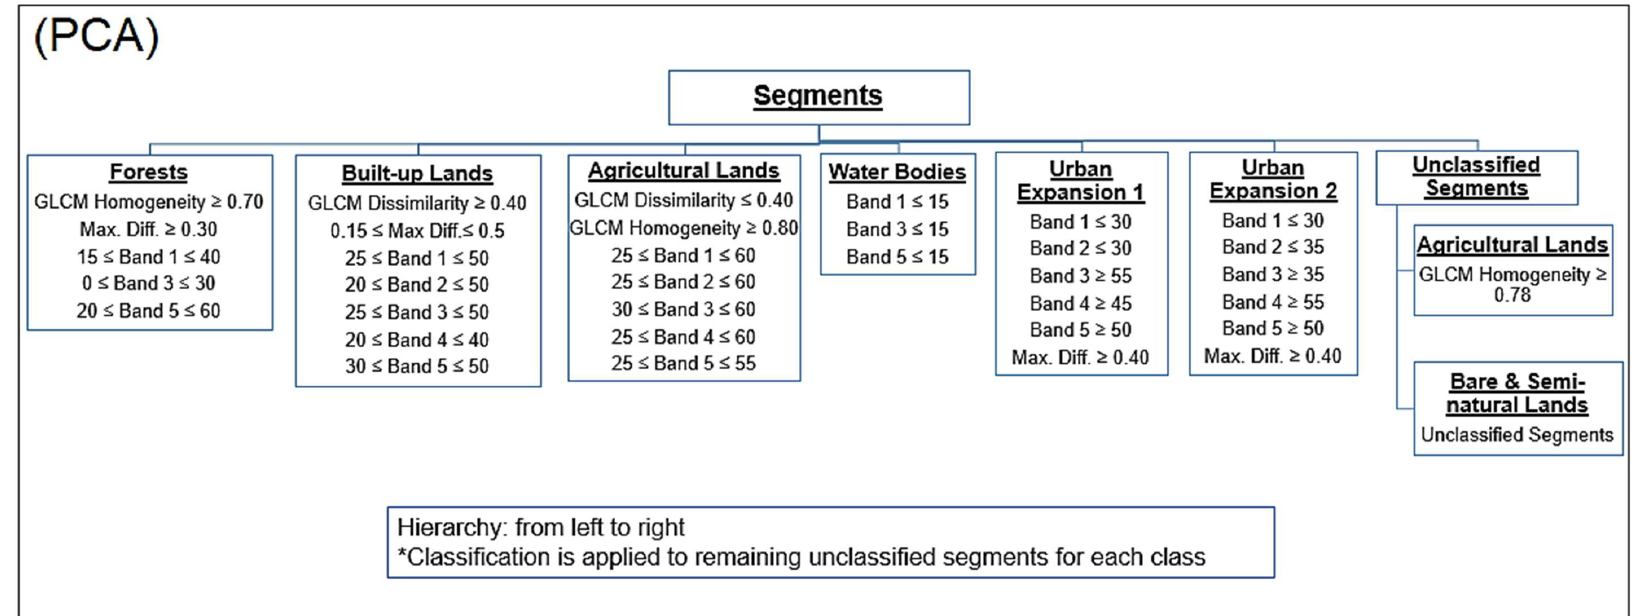
Figure A2. Threshold-based decision tree structure for the PCA dataset.